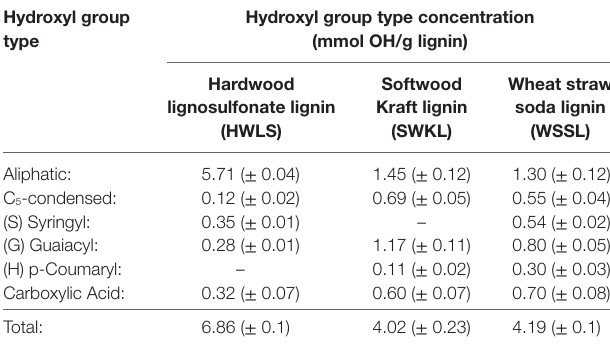
TaBle 2 | Hydroxyl group type concentrations for each lignin source determined by 31